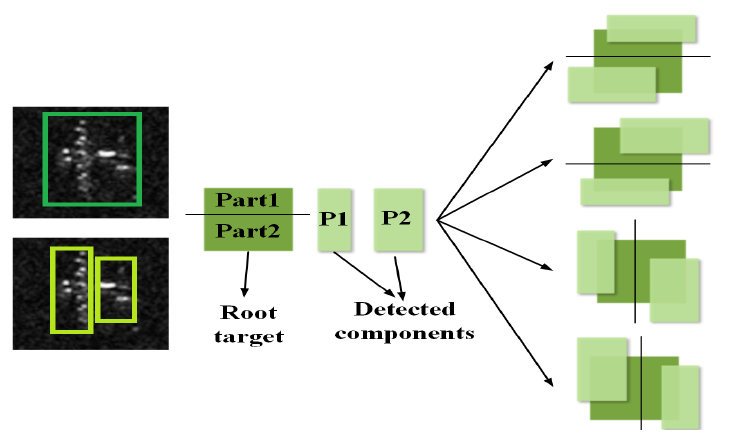
Figure 2. Four possible component locations on the root